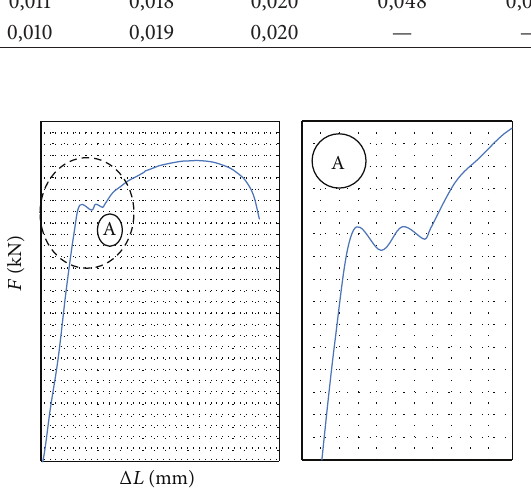
Figure 1: Relationship between loading force and elongation at stat- ic tensile